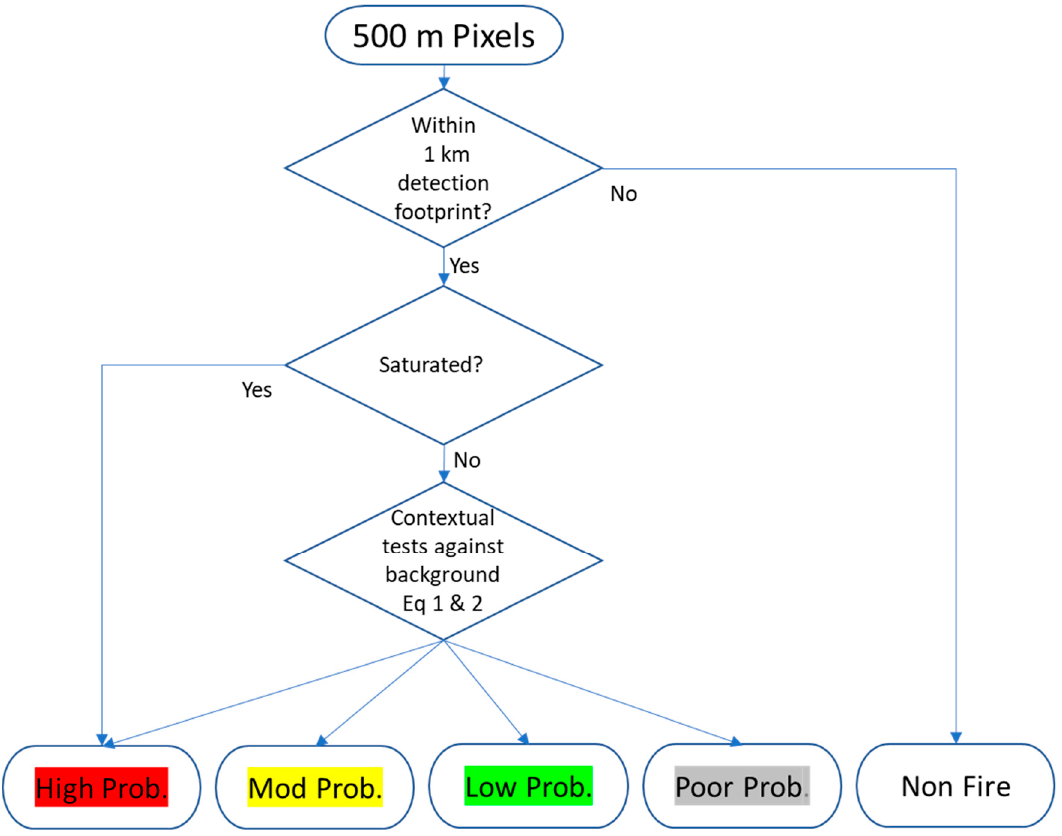
Figure 1. Downscaling algorithm flowchart.